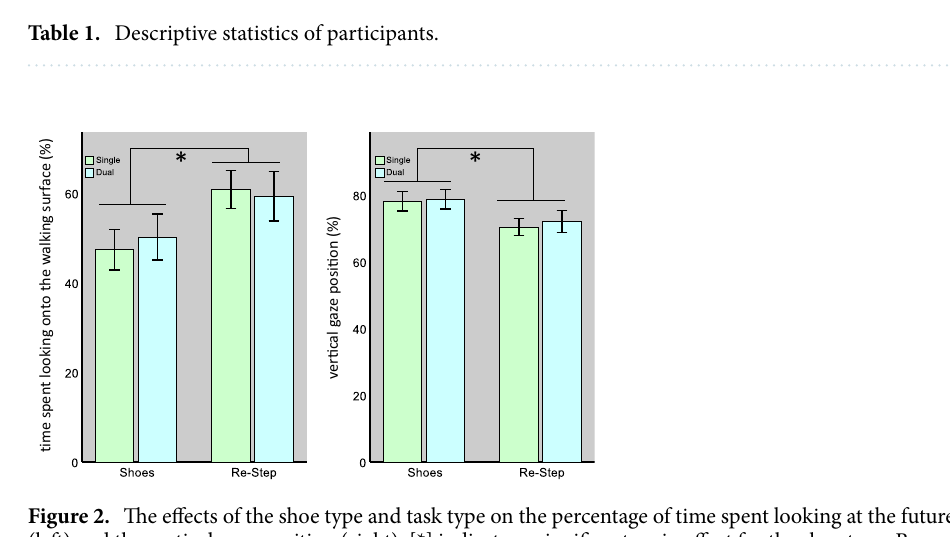
Figure 2. The effects of the shoe type and task type on the percentage of time spent looking at the future path (left) and the vertical gaze position (right). [*] indicates a significant main effect for the shoe type. Bars represent mean values, and error bars the 95% CI of the